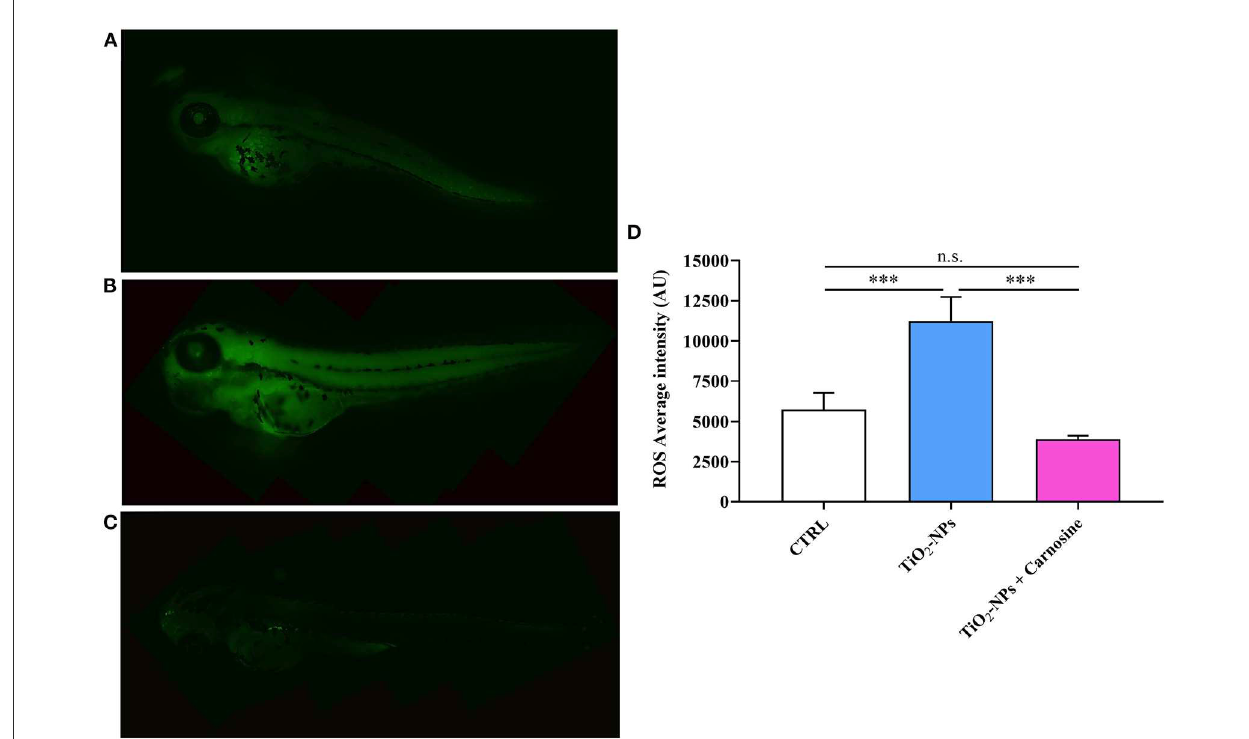
FIGURE5 Total ROS production in (A) untreated larvae, (B) TiO 2 -NPs-treated larvae, and (C) TiO 2 -NPs-treated larvae in the presence of carnosine 20mM (1h pre-treatment). Carnosine was kept during the exposure to TiO 2 -NPs. The average fluorescence intensity (AU) of at least 5 values for fixed larva is reported in (D) . SD is represented by vertical bars. ***Significantly different, p < 0.001. n.s., not significant.